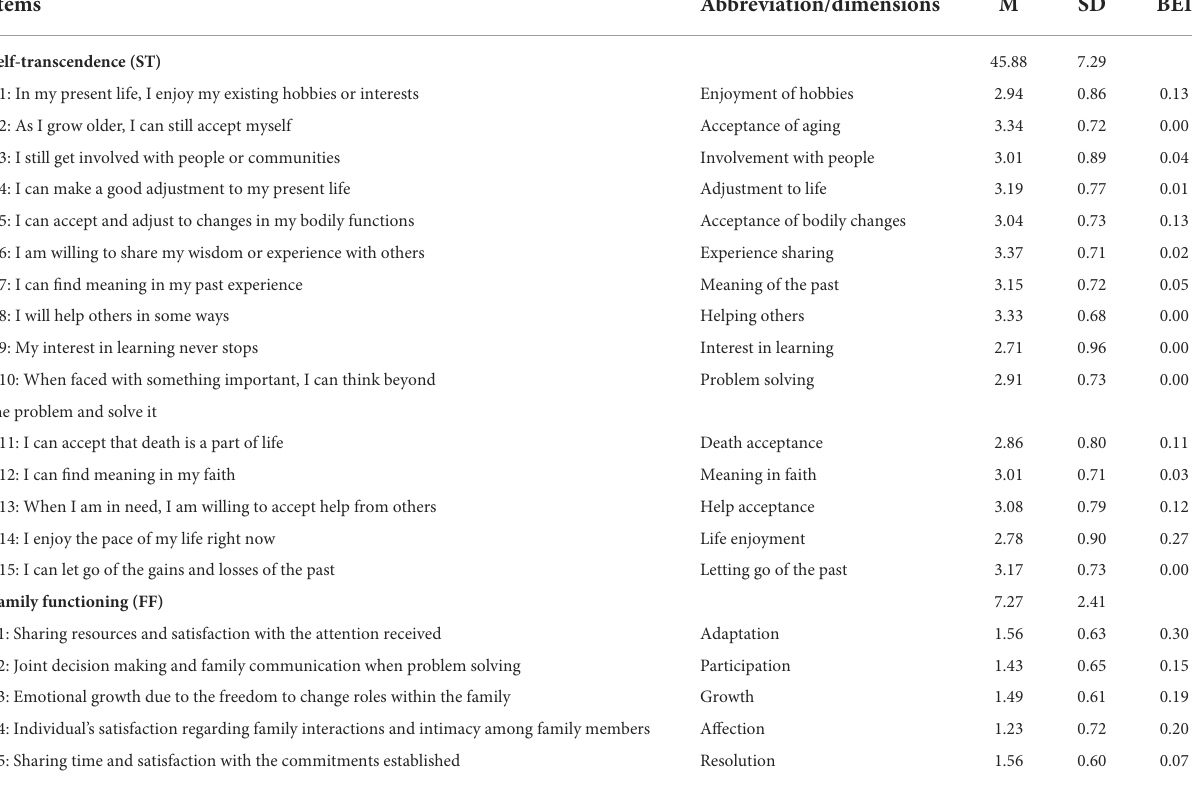
TABLE 2 Mean scores, standard deviations and abbreviations for each item on self-transcendence and family functioning. Items